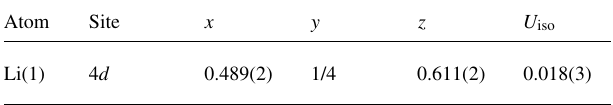
Table 2. Atomic coordinates and displacement parameters (in Å 2 )